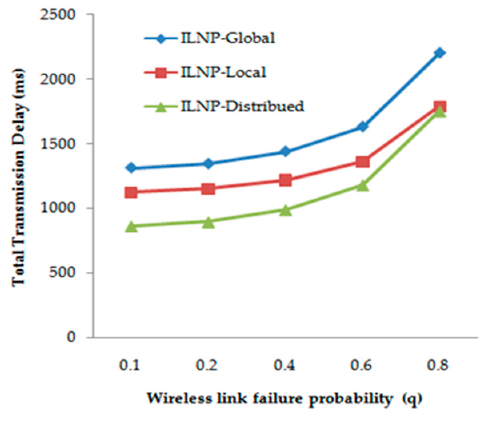
Figure 19. Impact of L wl on TTD.